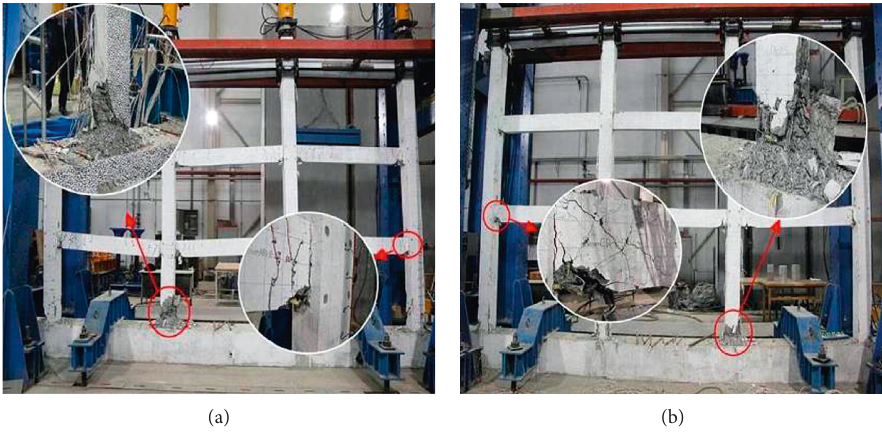
Figure 10: Failure modes of test frames. (a) KJ-1. (b)